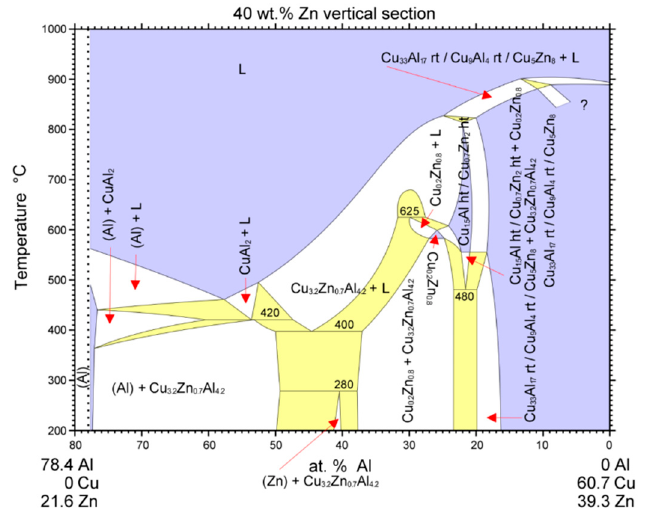
Figure 17. Isopletic section of ternary system Al-Cu for 40 wt % of Zn [22].